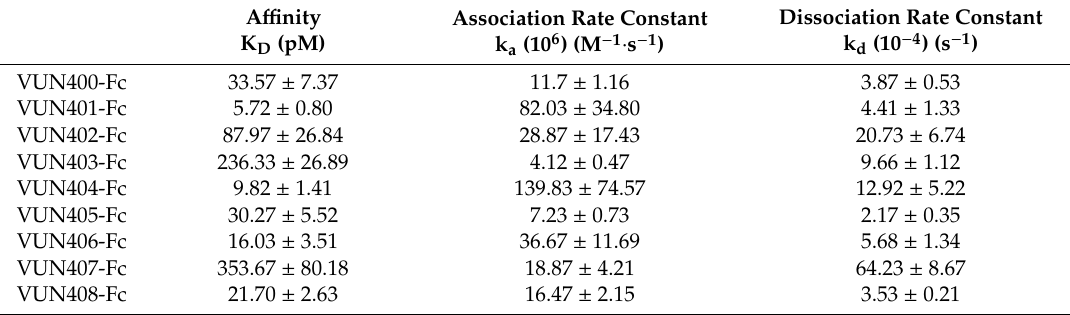
Table 1. A ffi nity (K D ), association rate constant (k a ) and dissociation rate constant (k d ) of the ten Nb-Fcs calculated using the 1:1 Langmuir